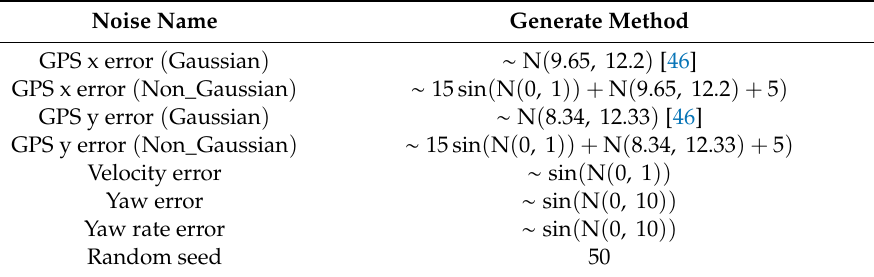
Table 3. Simulated noisy environment setting.